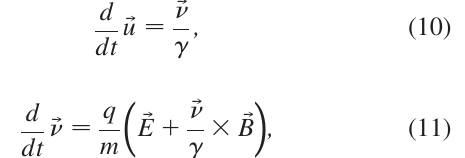
FIG. 1. Staggered grid doublet in FIT. The primary grid and its associated quantities are depicted in black, the dual grid in